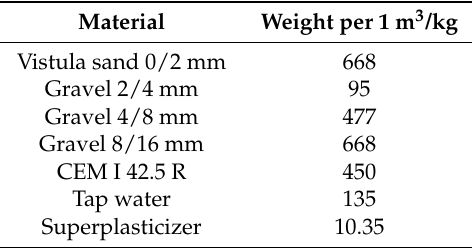
Table 4. Composition of the reference concrete mix (SAP REF).